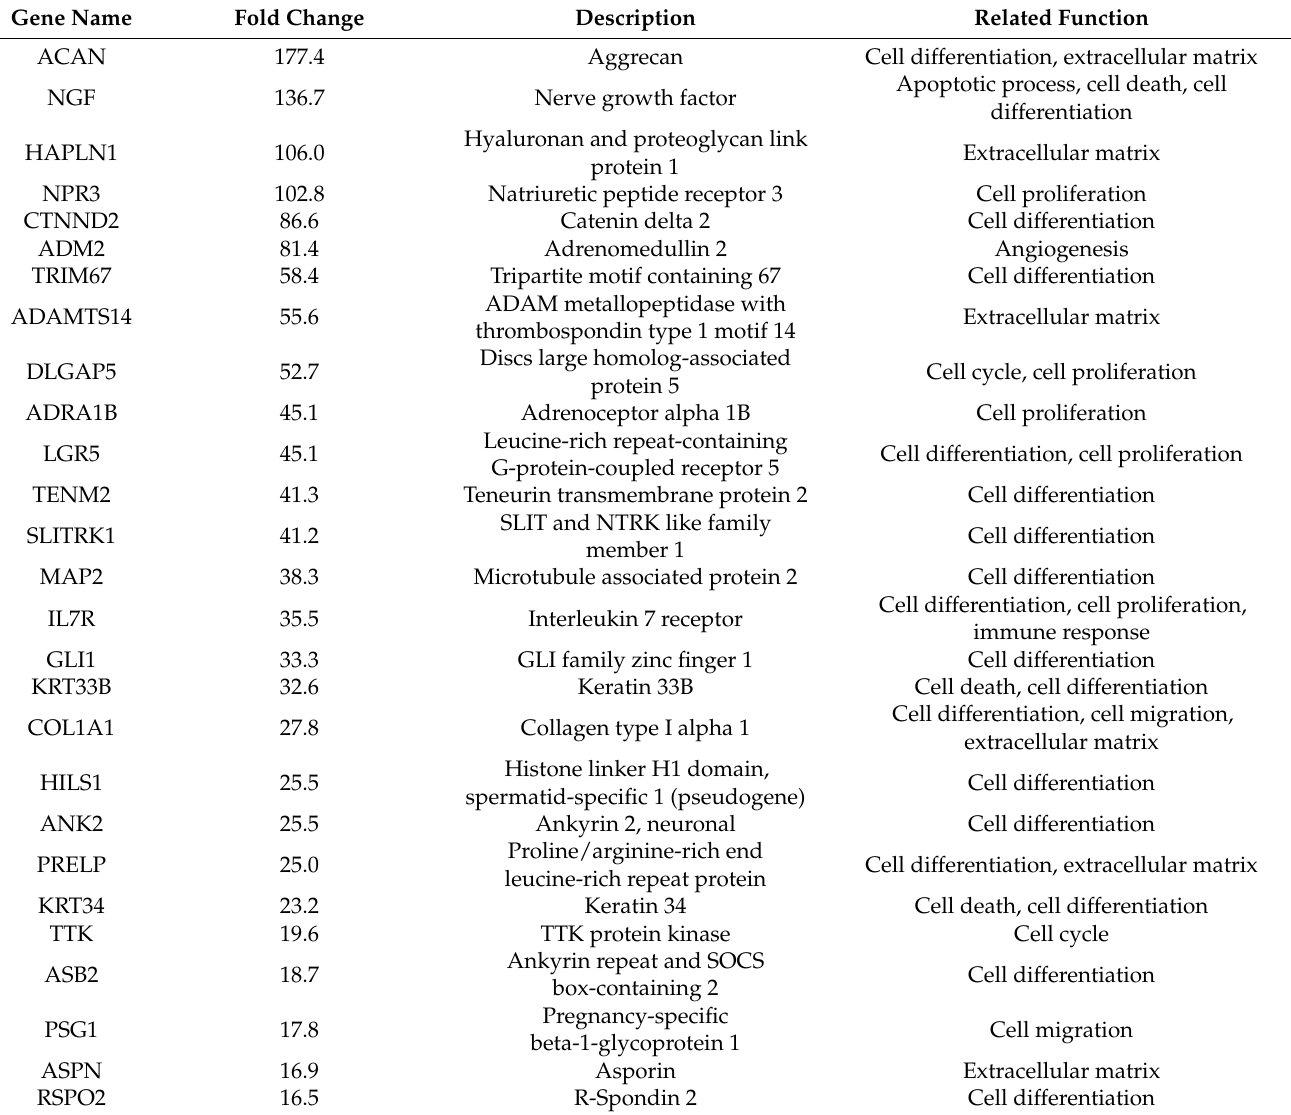
Table 2. Genes downregulated >10-fold in 3D- compared to 2D-cultured